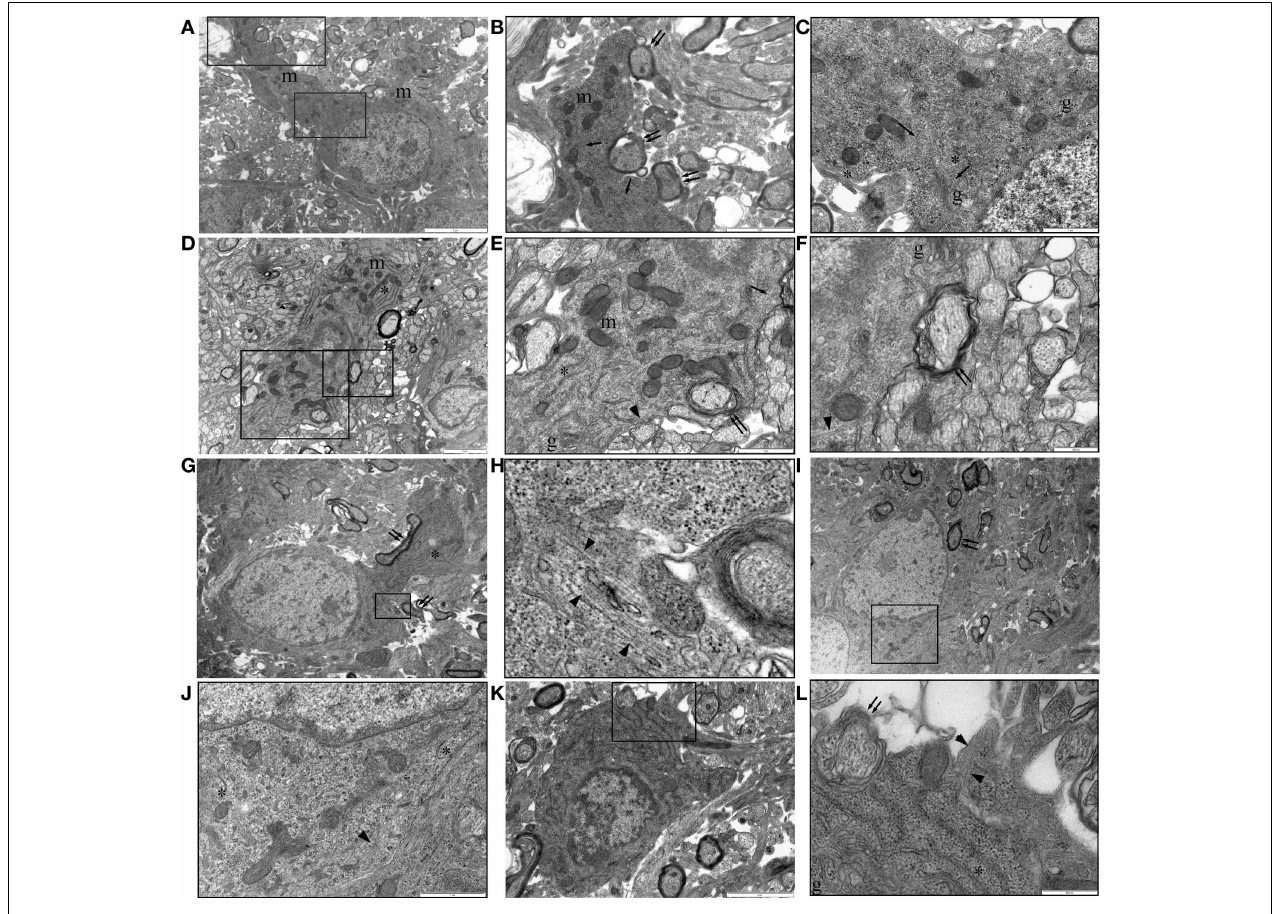
(arrow heads) are present in the cytoplasm. A large process is actively myelinating several large-diameter axons (double arrows). (G,H) An otherwise typical oligodendrocyte that is actively myelinated several axons (double arrows) contains a small area of glial filaments (arrow head). (I,J) Further example of a myelinating (double arrow) oligodendrocyte (boxed area shown at higher gain in “ J ”) containing glial filaments (arrow head). In both cases, note the typical narrow-bore ER (“ * ”) and nuclear morphology. (K,L) A less mature oligodendrocyte (note size and nuclear morphology) is starting to ensheath an axon (double arrows) and contains a glial filament bundle (arrow